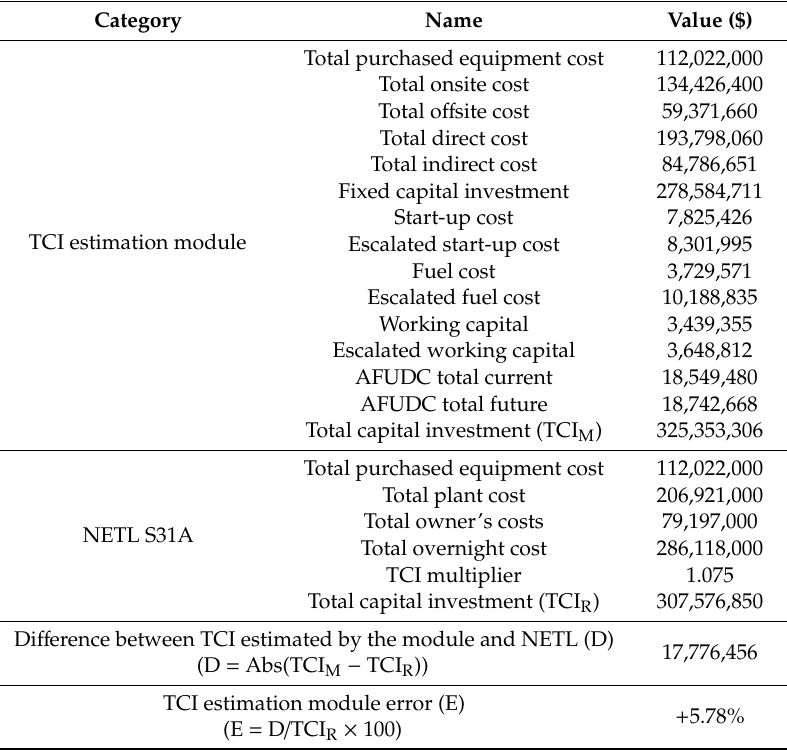
Table 8. Calculation accuracy of developed TCI